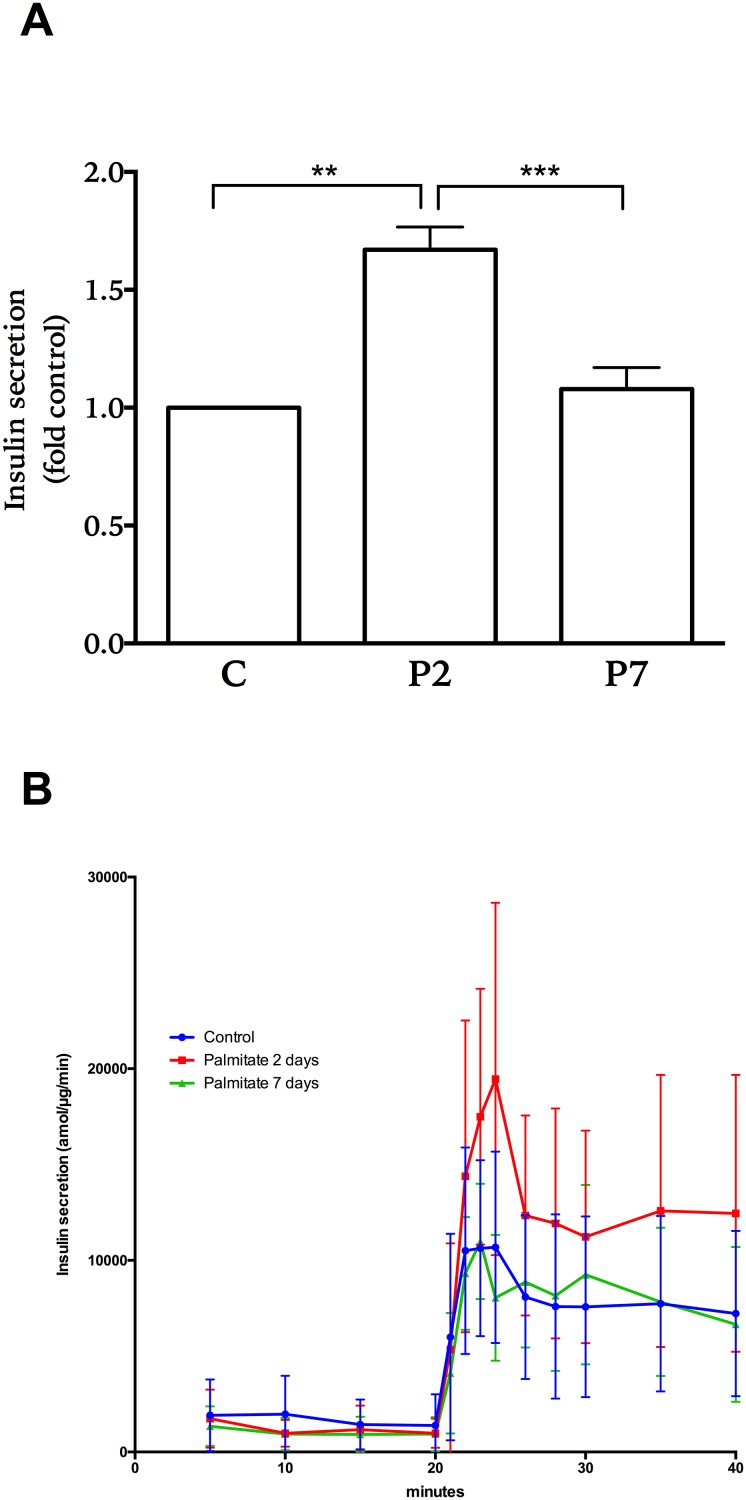
Glucose-stimulated insulin secretion from human islets treated with palmitate.Islets were treated with palmitate for two (P2) and seven (P7) days or without it in control conditions (C). Subsequently post culture, insulin secretion during glucose stimulation was assessed by perifusing islets with a buffer containing 2 mM glucose (first 20 minutes) followed by 20 mM glucose (last 20 minutes). Total amount of insulin secreted during glucose stimulation (A) and the kinetic secretory responses (B) are shown. Secretion amount from 6 donors was adjusted to total islet protein amount. Results show means ± SEM as fold control in panel A and ± SD in panel B. ** P<0.005 and *** P<0.0005 vs control.